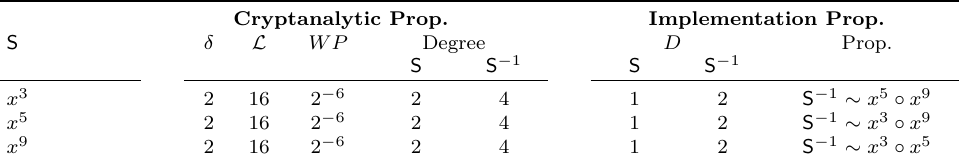
Table 6: Minimal-depth 7-bit S-boxes